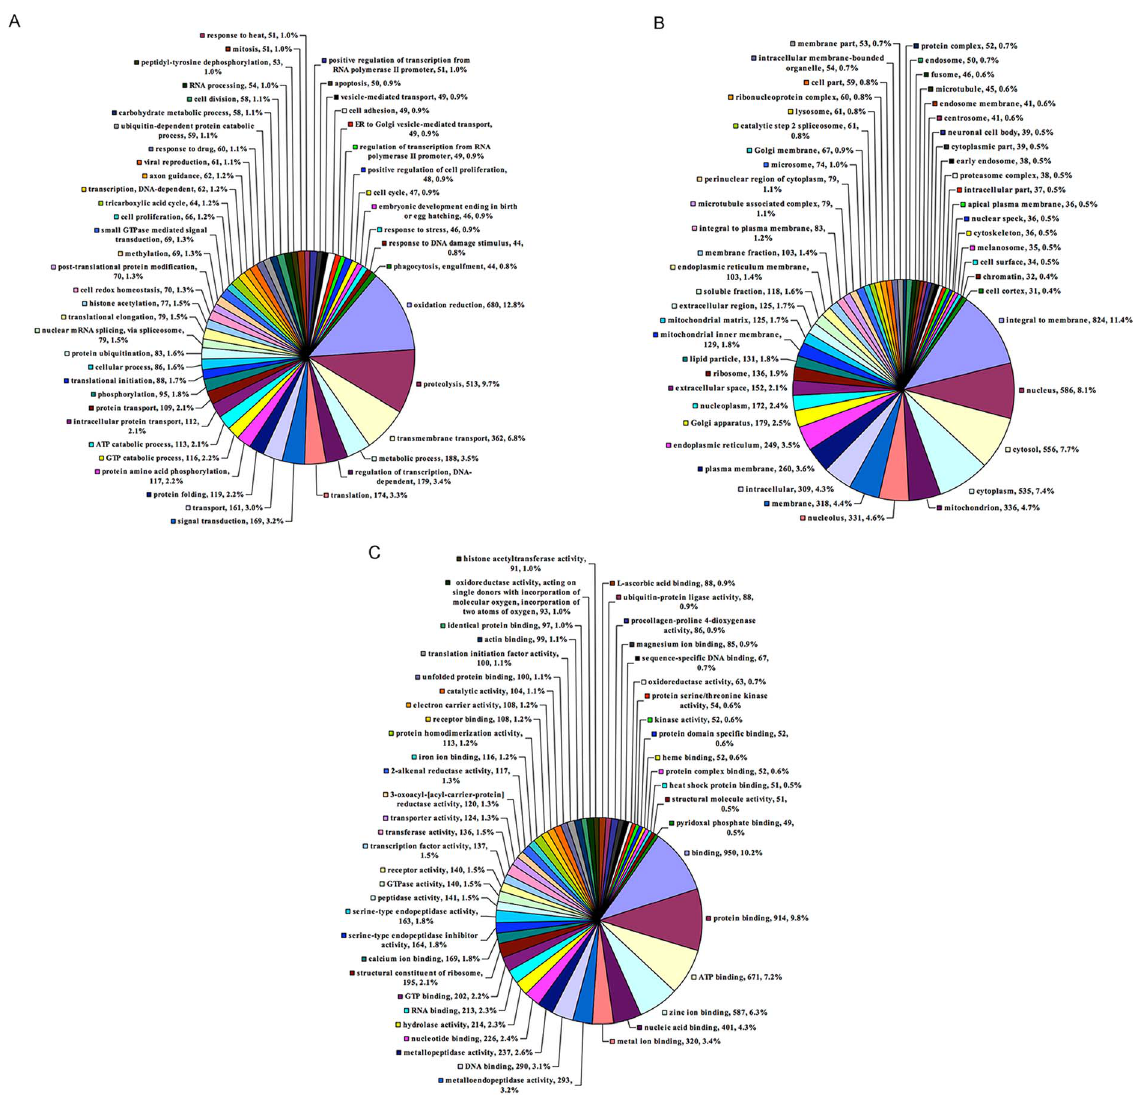
Figure 3. Gene ontology assignments of transcripts expressed in B.henselae- infected and non-infected I.ricinus female salivary glands: A) Biological progresses, B) Cellular components, C) Molecular functions.